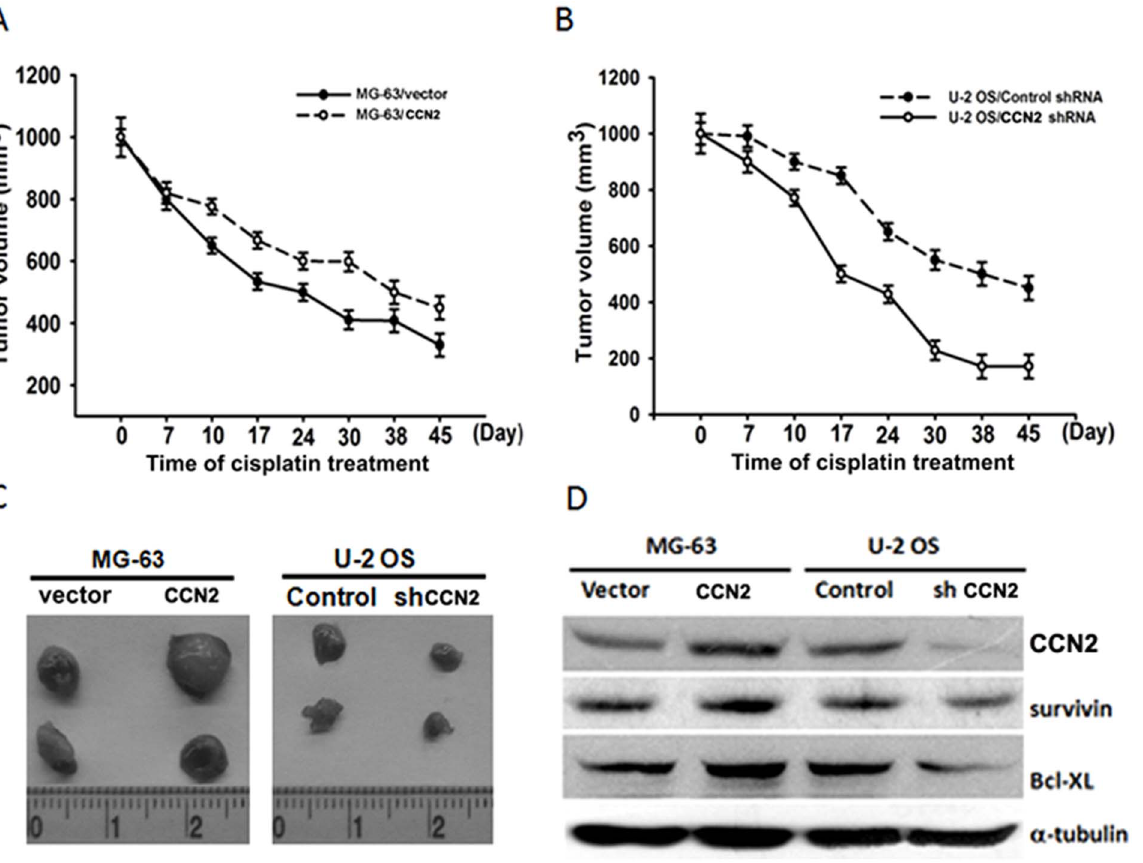
Figure 6. CCN2 enhances resistance to cisplatin in a mouse xenograft model. (A & B) Tumor growth curves of human osteosarcoma cells, which were treated with cisplatin for 45 days. (C) Representative photographs of MG-63/vector, MG-63/CCN2, U-2 OS/control shRNA, and U-2 OS/ CCN2 shRNA cells from nude mice. (D) Western blotting was used to determine the protein levels of CCN2, Bcl-xL, survivin, and a -tubulin in tumor cells. Results are expressed as the mean 6